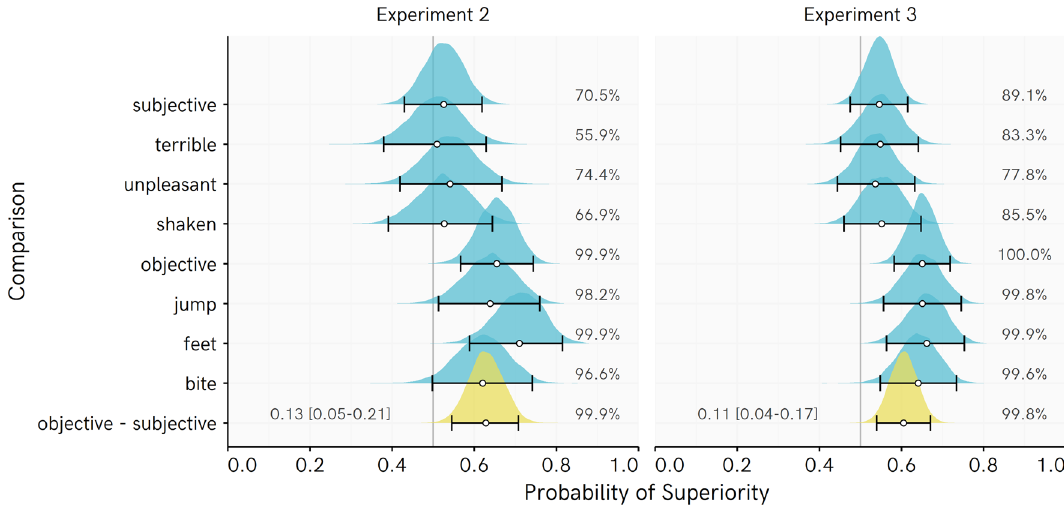
Figure 4. Posterior distribution of regression-based probability of superiority (PSup) estimates for Experiments 2 and 3. Each PSup value represents an estimate of the probability that a randomly picked Control score is higher than a randomly picked Bet score. Percentages indicate the proportion of the posterior PSup estimate > 0.5 (e.g., for objective events, 97% or more of every posterior is over 0.5, indicating very consistently higher ratings among Control than Bet participants). Points represent posterior median, whiskers represent 95% HDI, ridge height reflects density of estimate. Objective–Subjective = difference in PSup estimates for average of Objective beliefs vs. the average of Subjective beliefs, with values above 0 indicating a greater difference between Control and Bet participants in Objective than Subjective beliefs, with posterior median and [95% highest density interval]. Note that position of this density ridge on the X axis has been shifted by 0.5 so that the line at 0.5 represents 0 (no difference in PSup estimates) for this posterior